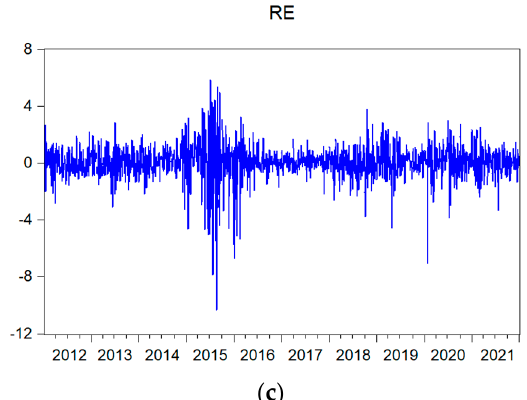
Figure 3. Wavelet-threshold denoising results of different indices. ( a ) TI. ( b ) FI. ( c ) RE.